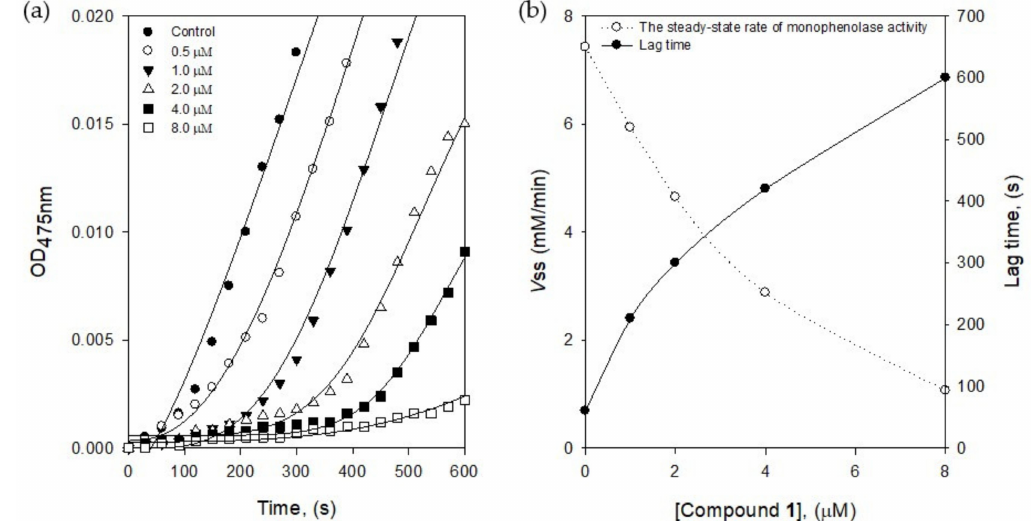
Figure 4. ( a ) Time course of oxidation of l -tyrosine catalyzed by tyrosinase in the presence of compound 1 at di ff erent concentrations (0, 0.5, 1.0, 2.0, 4.0, and 8.0 µ M) ( b ) The steady-state rate of monophenolase activity and the lag period of monophenolase for the oxidation of l